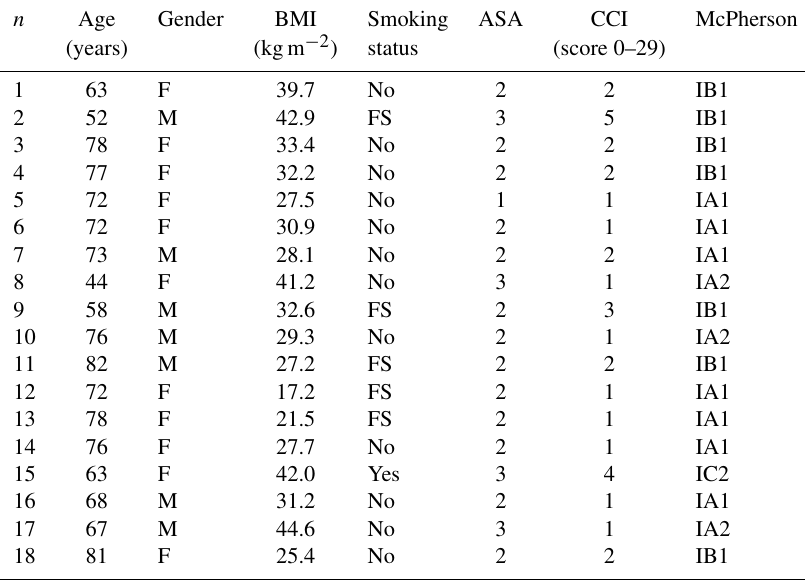
Table 1. Patient